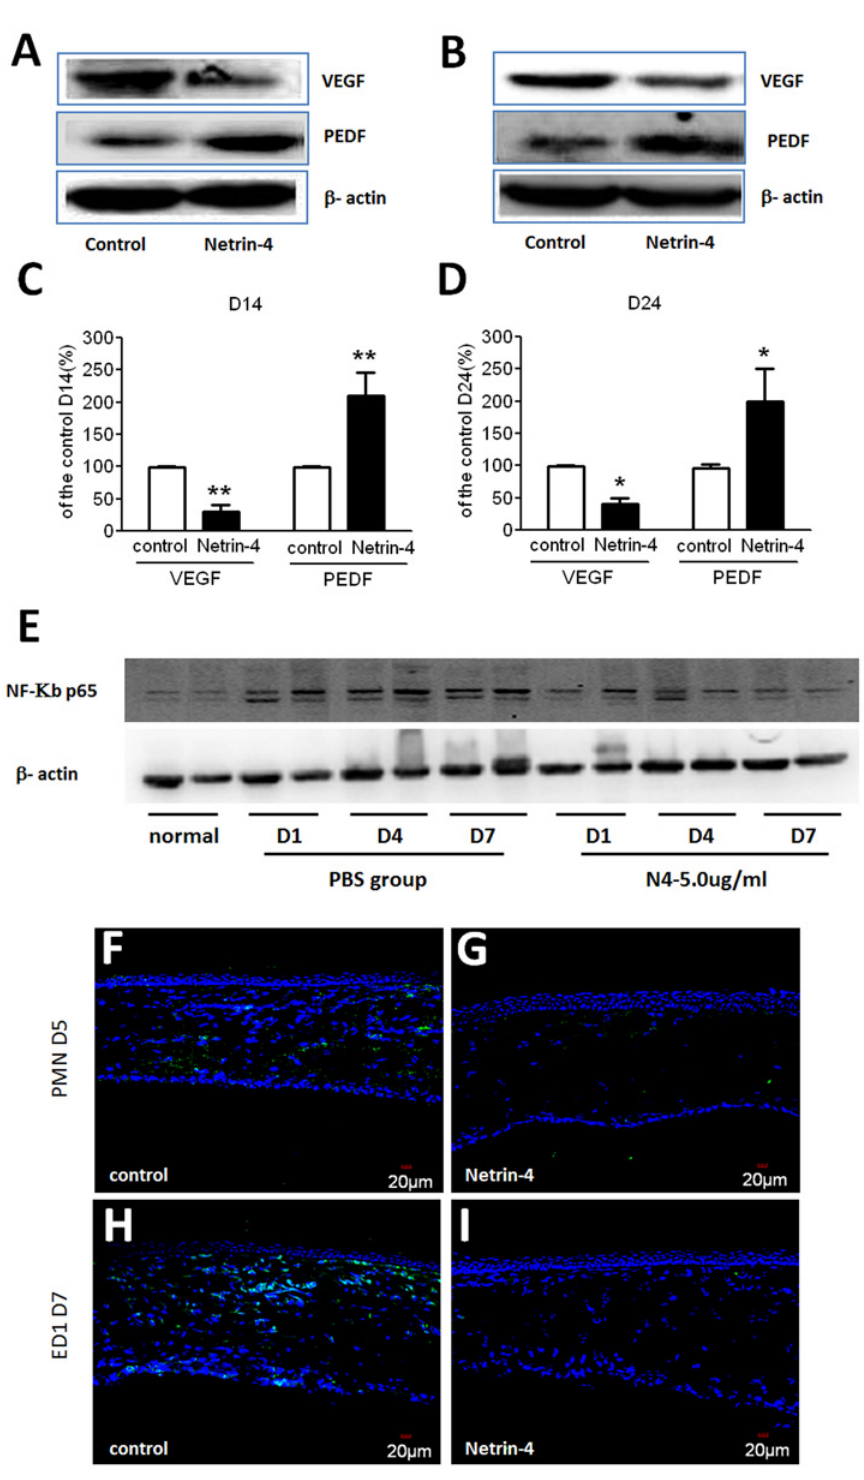
Fig 7. Effect of netrin-4 on VEGF, PEDF, NF-KB p65, PMN and ED1(CD68) expression after corneal alkali burns. (A) Western blot analysis results showed that VEGF was expressed at low levels in normal rat cornea, while there was a dramatic increase at day 14 (D14) after alkali burns in the control group. In the late stage treatment experiment, there was a decrease in VEGF on day 24 (D24). In the netrin-4 treatment group, there was a dramatic down regulation of VEGF on day 14 and day 24. PEDF was expressed in